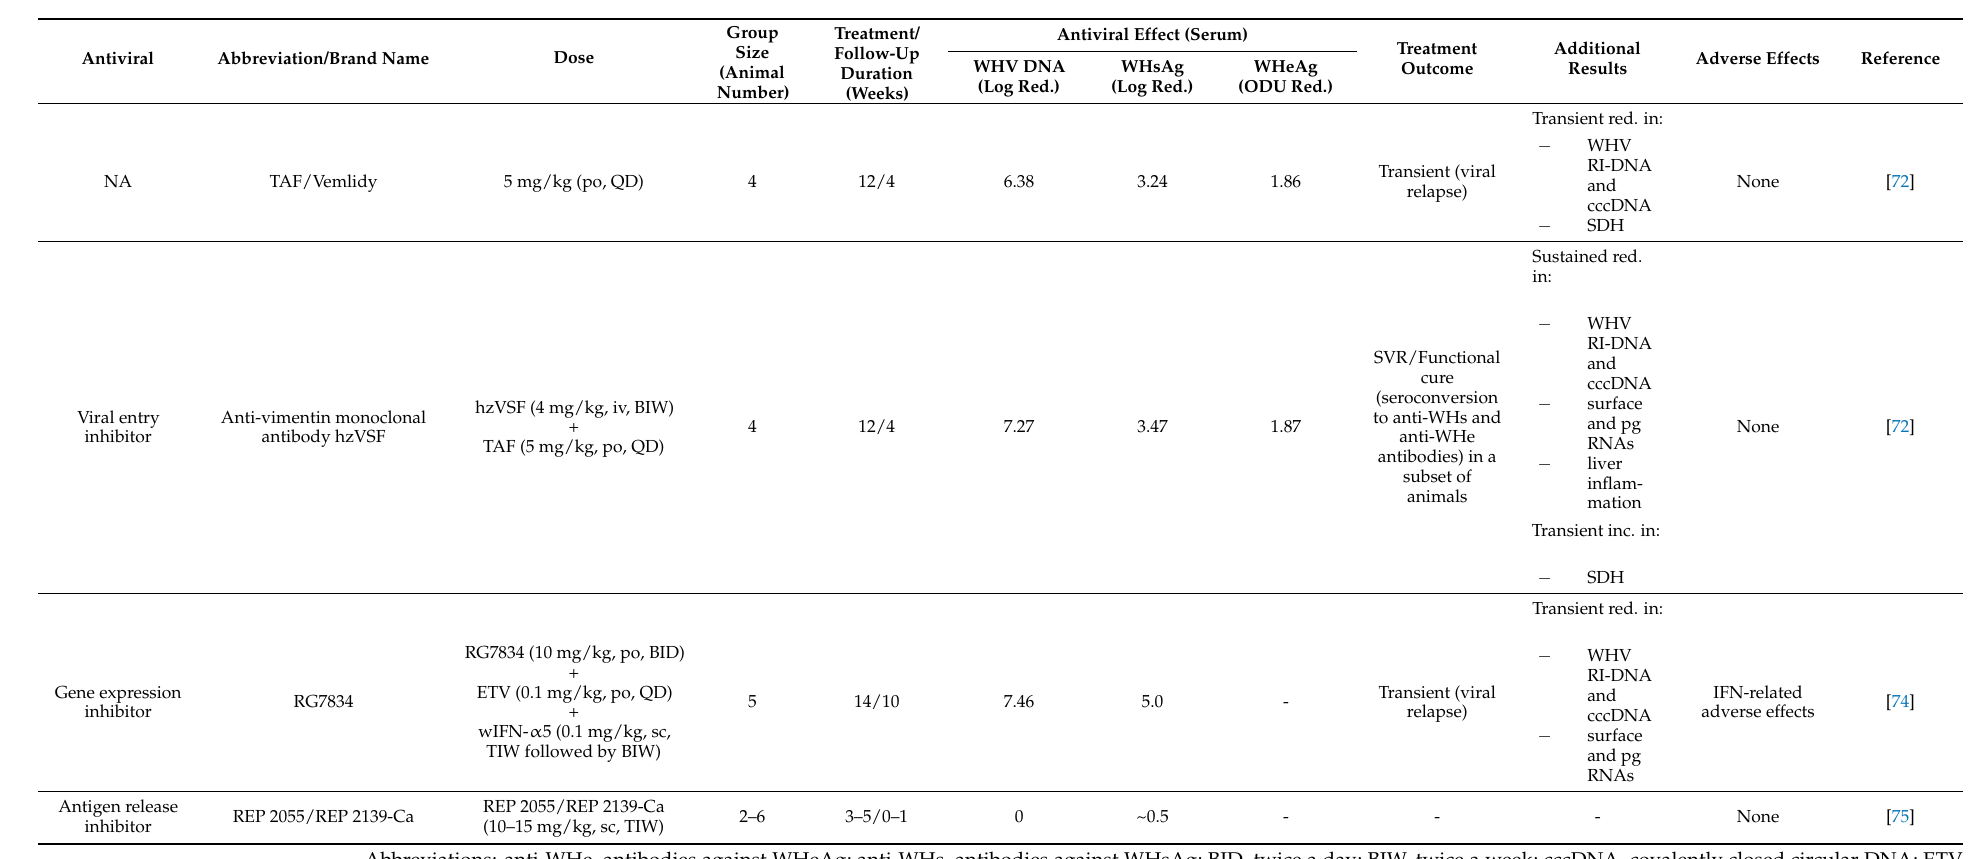
Table 1. NAs and DAAs recently evaluated in the woodchuck for safety and antiviral efficacy against CHB.